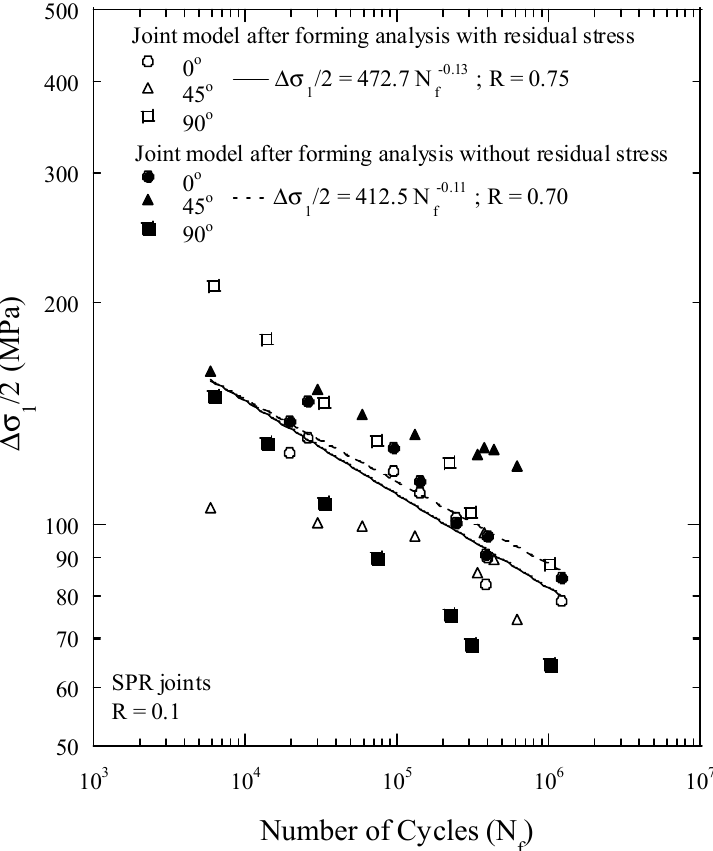
Figure 14. Comparison of fatigue lifetimes of SPR joint profile models according to a joining analysis with and without residual stress as a function of the maximum principal stress.